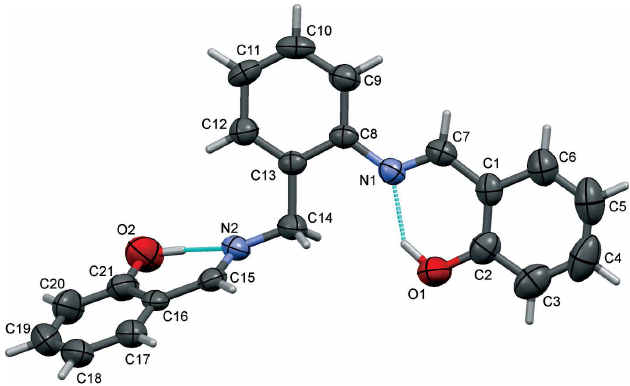
Figure 1 The molecular structure of the title compound, showing the atomic numbering and displacement ellipsoids drawn at the 30% probability level. The intramolecular O—H (cid:2)(cid:2)(cid:2) N hydrogen bonds are shown as dashed lines (see Table